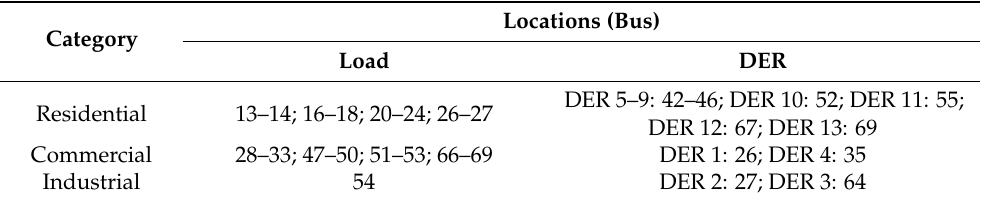
Table 2. Load and DER location by the customer types in test system.